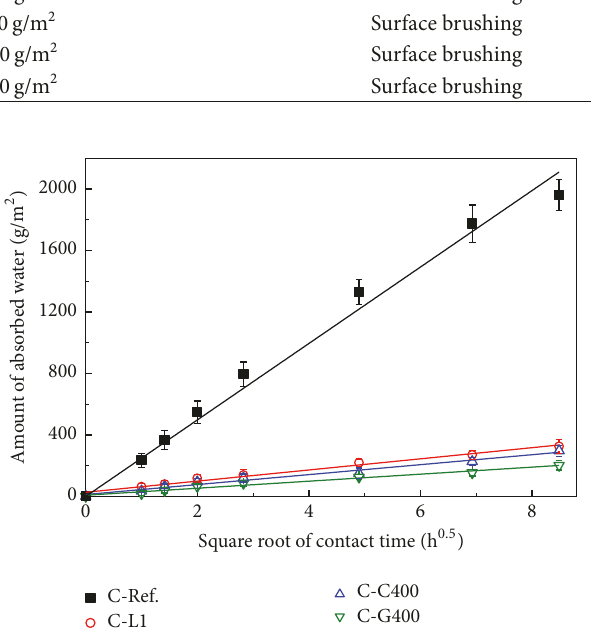
Figure 5: The amount of absorbed water in surface impregnated and untreated concrete at different time of water absorption and the linear fitting